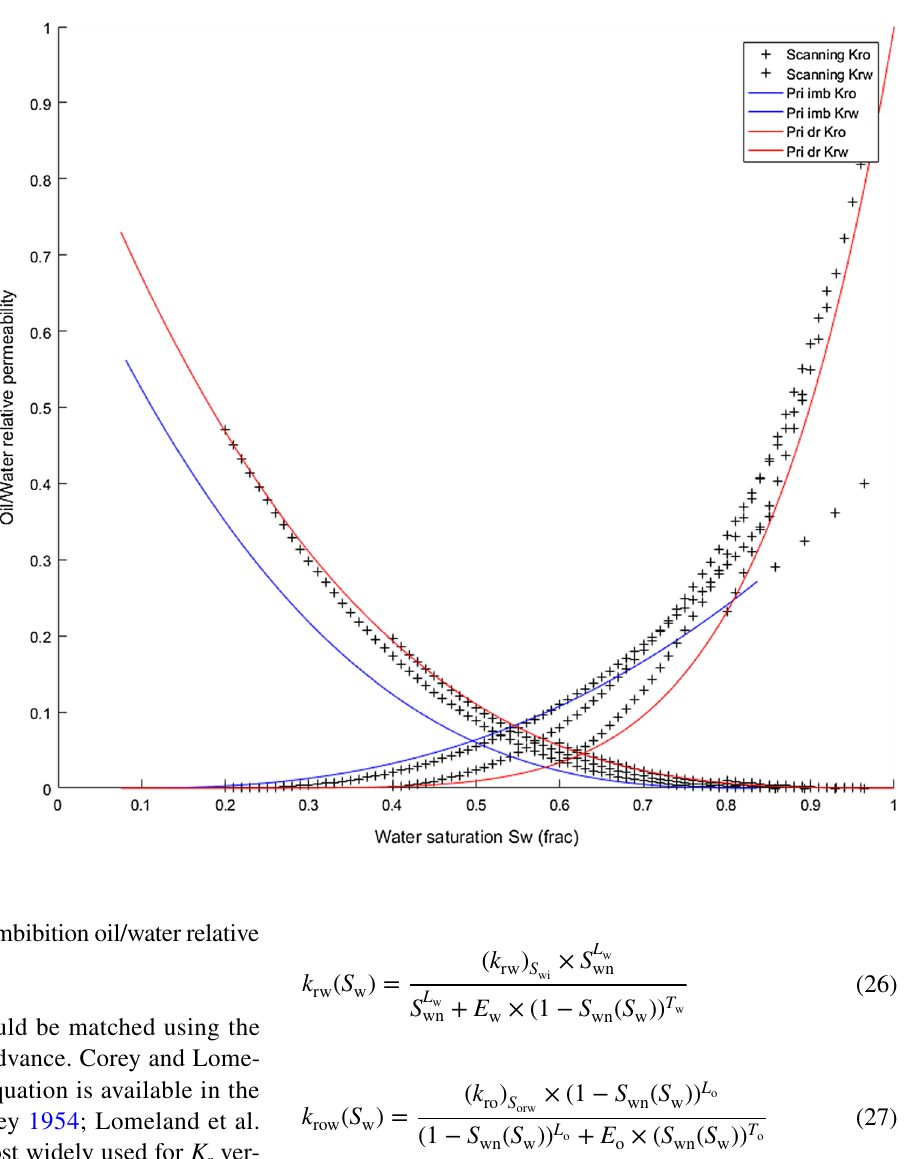
Fig. 15 Bounding drainage/ imbibition curve and scan- ning curve for rock type 3 (Masalmeh model, linear-type S S oi / or